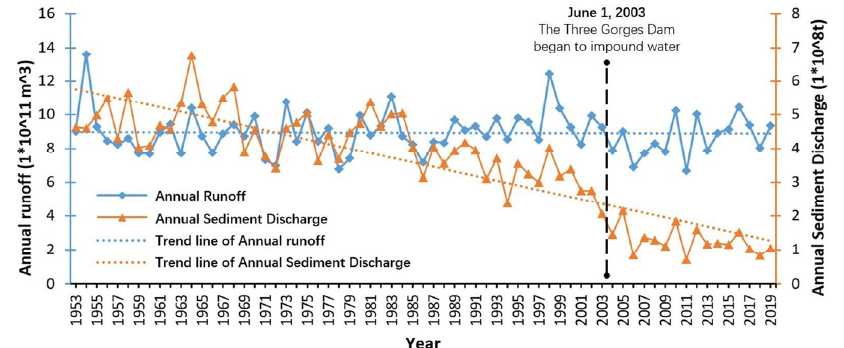
Figure 9. Annual runoff and annual sediment discharge recorded by Datong Station (the represen- tative hydrological station) from 2000 to 2019. Data are from the Chinese River Sediment Bulletin, Ministry of Water Resources,